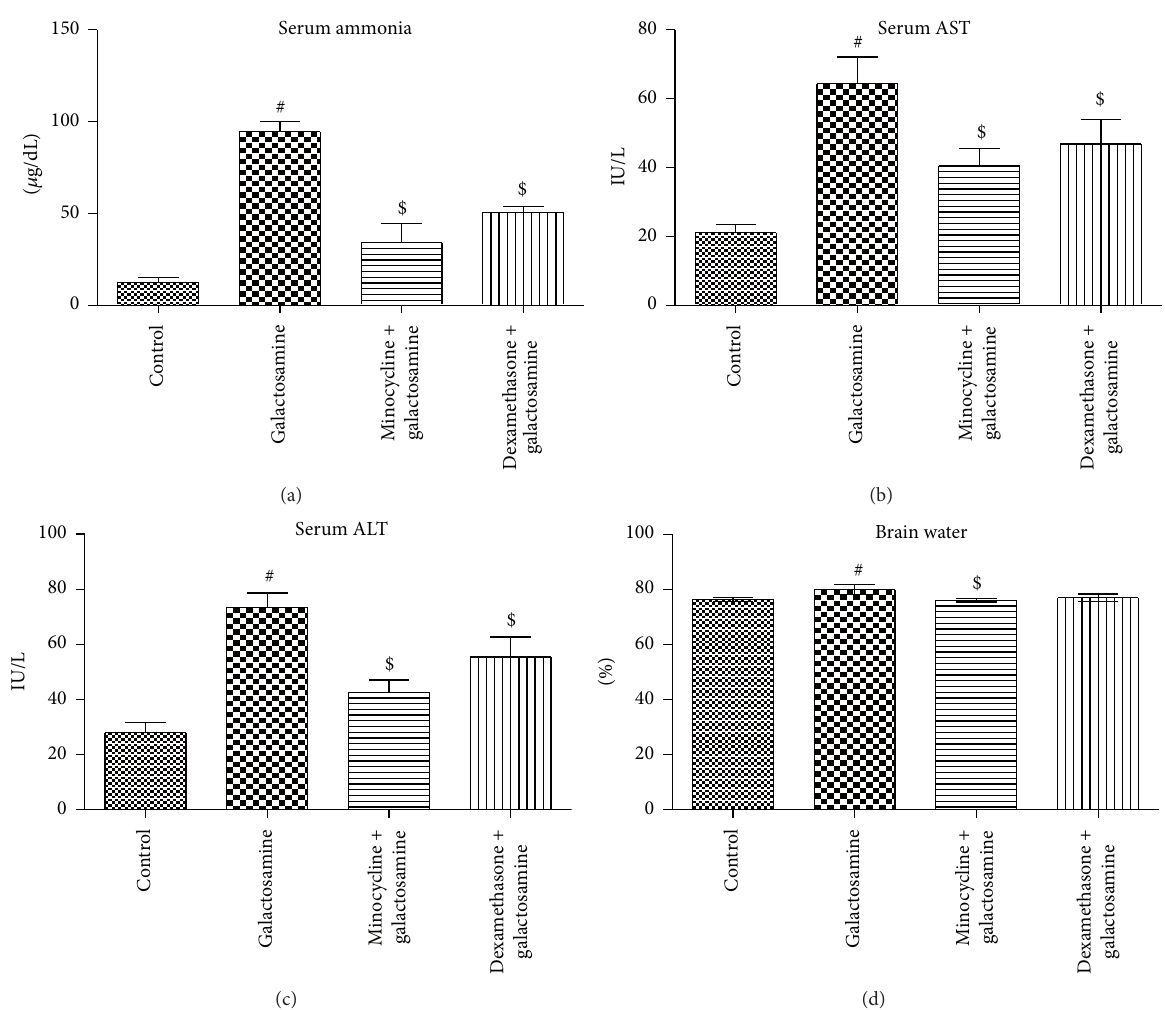
Figure 3: The effects of minocycline and dexamethasone on the acute liver injury and brain oedema. Both dexamethasone and minocycline ( 𝑛 = 6 per group) reduced the levels of serum ammonia ( 𝜇 g/dL) (a), AST (IU/L) (b), ALT (IU/L) (c), and the brain water (%) (d) associated with acute liver injury. All values are expressed in means ± SD. # 𝑃 < 0.05 versus control; $ 𝑃 < 0.05 versus galactosamine treated group.